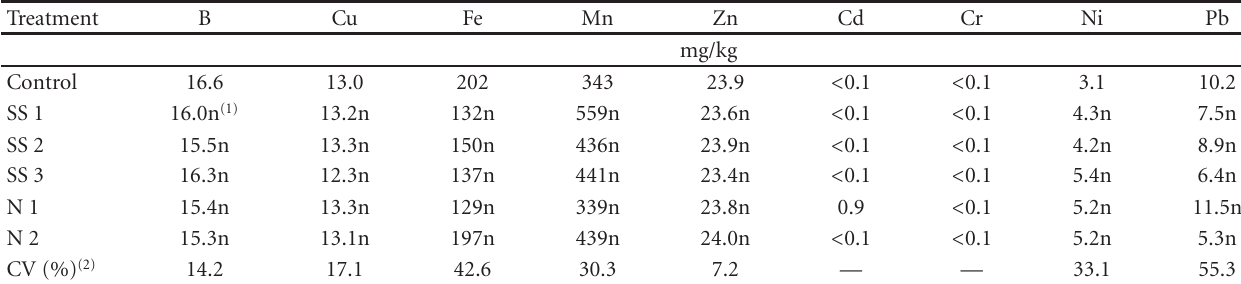
Table 5: Micronutrient and heavy metal concentrations in the index-leaf of banana plants from plots treated with biosolids (SS) and mineral N fertilizer